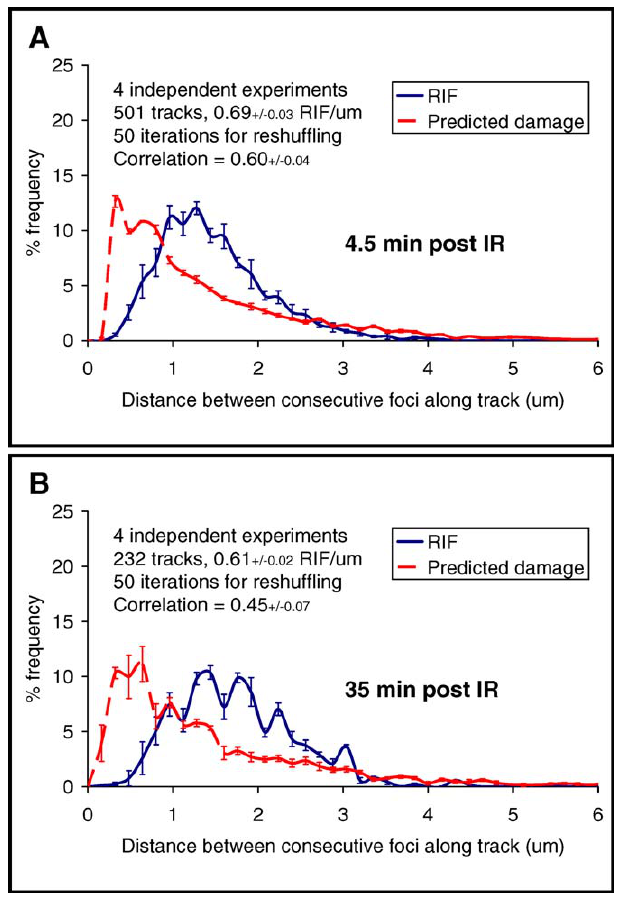
Figure 4. Comparing Theoretical and Experimental DNA Damage Pattern along 1 GeV/amu Fe Track Average distributions of distances between consecutive foci along Fe tracks are plotted at 4.5 min and 35 min following 1 Gy exposure (blue solid lines, (A) and (B), respectively). Error bars are standard errors based on four independent experiments. For each individual track analyzed from real data, foci were counted and their positions were then randomized based on DNA profiles, described previously, to generate a theoretical distribution pattern (red dashed lines). Measuring the correlation between theoretical and experimental distributions, we observe a decrease of correlation between these two time points, from 0.6 to 0.45. These data indicate that as early as 4.5 min following exposure to radiation, foci positions deviate from a theoretical random behavior by 40% and this tendency increases over the next 30 min with